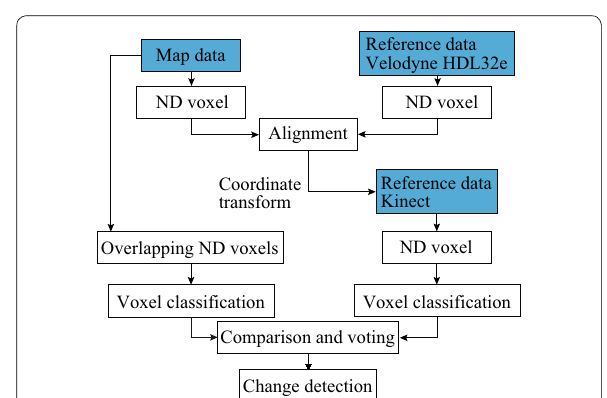
Fig. 6 Procedure of localization and spatial change